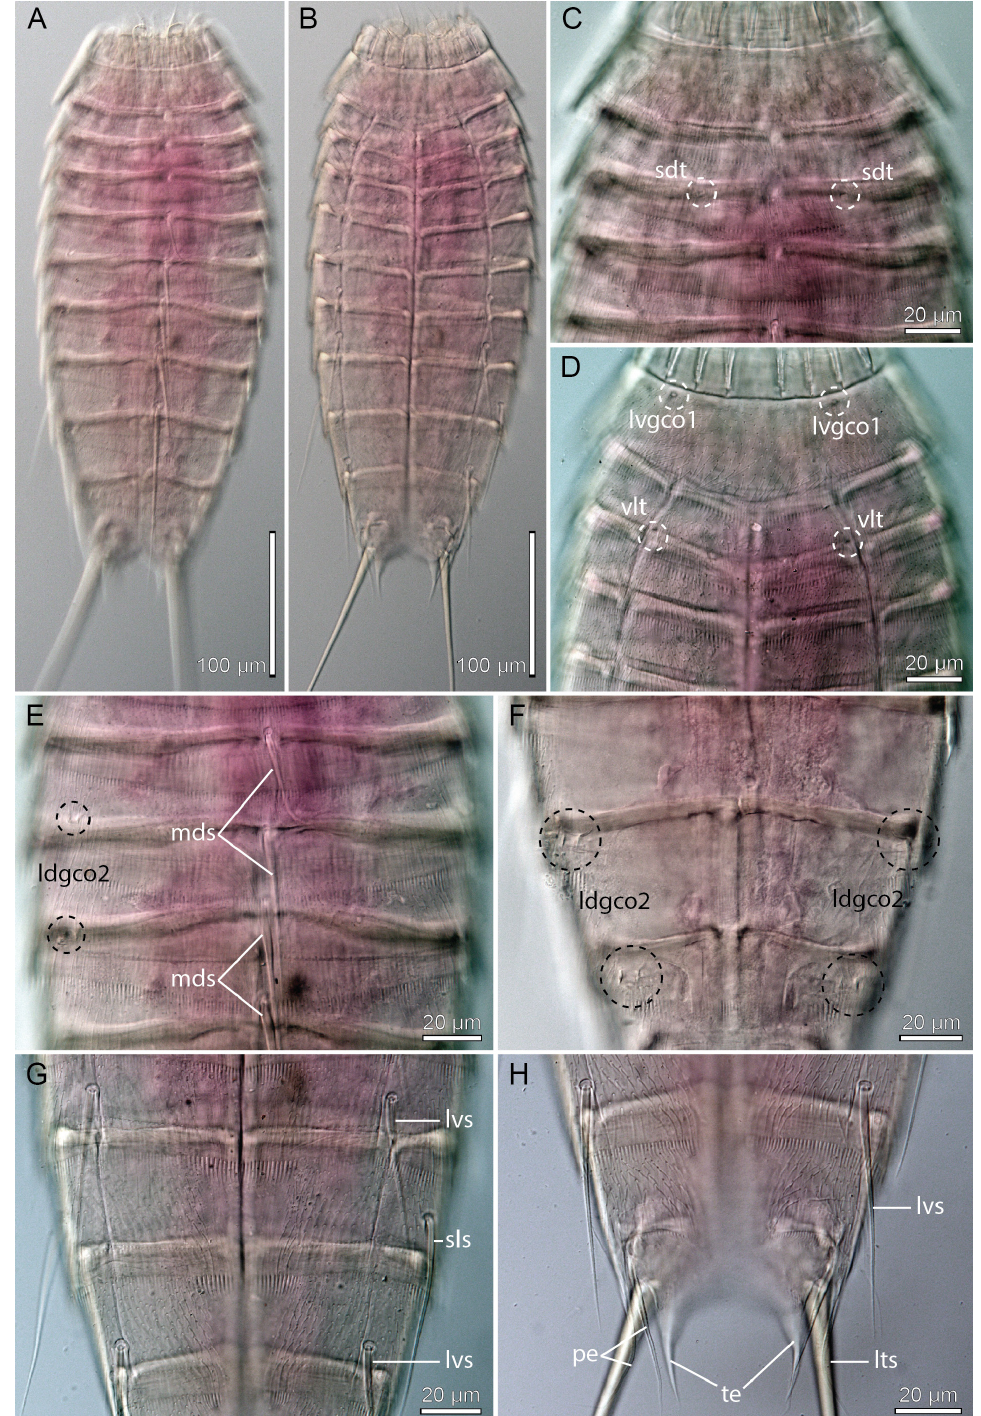
Fig. 26. Light micrographs showing overviews and details of Fissuroderes higginsi Neuhaus & Blasche, 2006, non-type, ♂ (NHMD-227025). A . Dorsal overview. B . Ventral overview. C . Segments 1 to 4, dorsal view. D . Segments 1 to 4, ventral view. E . Segments 4 to 7, dorsal view. F . Segments 8 to 10, dorsal view. G . Segments 7 to 10, ventral view. H . Segments 10 to 11, ventral view. Abbreviations: ldgco2 = laterodorsal glandular cell outlet type 2; lts = lateral terminal spine; lvgco1 = lateroventral glandular cell outlet type 1; lvs = lateroventral spine; mds = middorsal spine; pe = penile spine; sdt = subdorsal tube; sls = sublateral spine; te = tergal extensions; vlt = ventrolateral